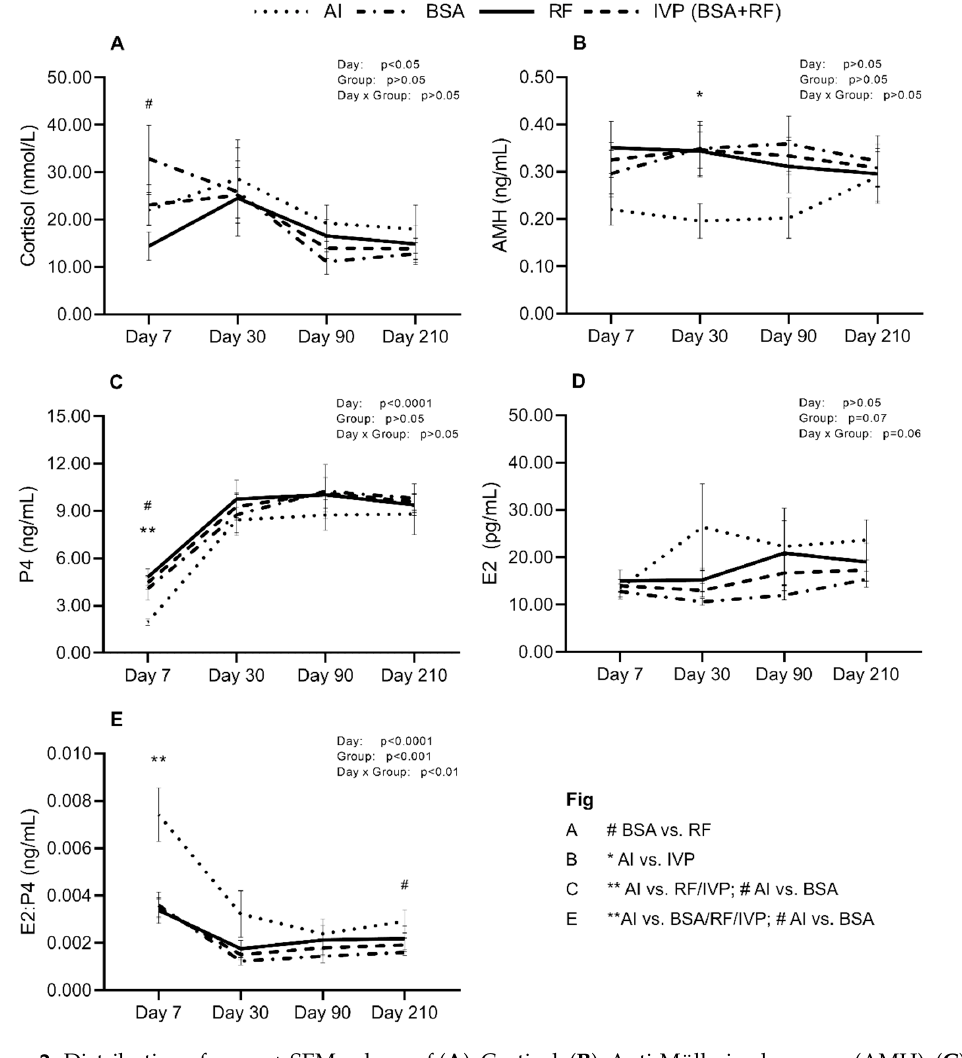
Figure 2. Distribution of mean ± SEM values, of ( A ). Cortisol, ( B ). Anti-Müllerian hormone (AMH), ( C ). Progesterone (P4), ( D ). Estrogen (E2) and ( E ). E2:P4 ratio, in pregnant recipients from artificial insemination (AI) group, bovine serum albumin group (BSA), reproductive fluids group (RF) or in vitro produced (IVP, corresponding of BSA + RF) across gestation time. * p < 0.05, ** p < 0.01 and # p < 0.09.